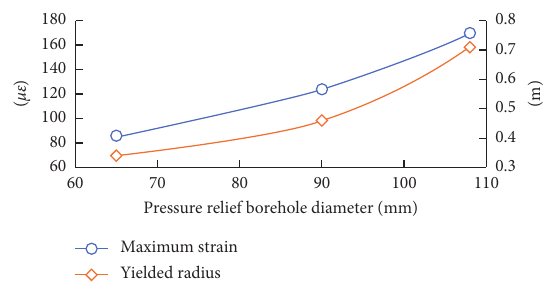
Figure 13: Strain change versus borehole diameter. Table 3: Statistics of strain between two boreholes versus the borehole spacing.